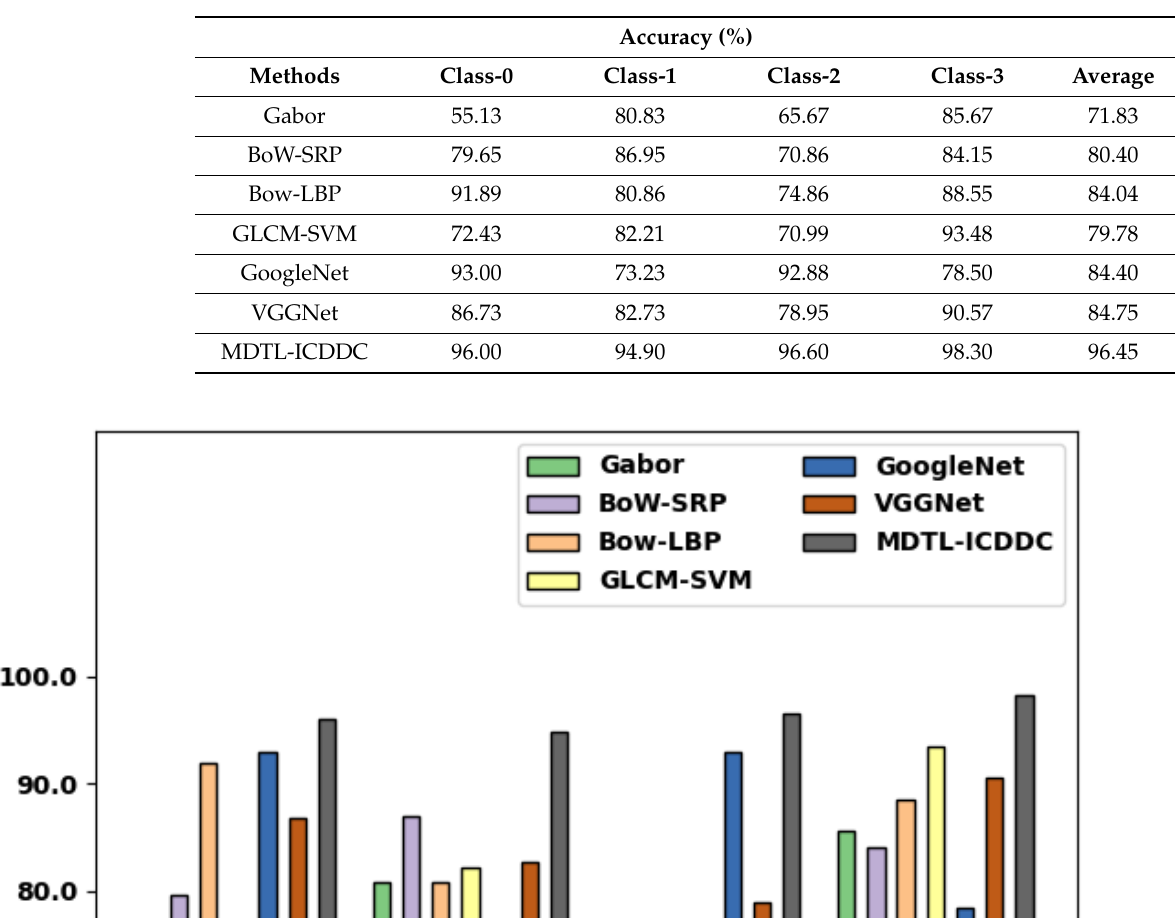
Table 6. F-score analysis of MDTL-ICDDC technique with existing algorithms under various clas- ses.